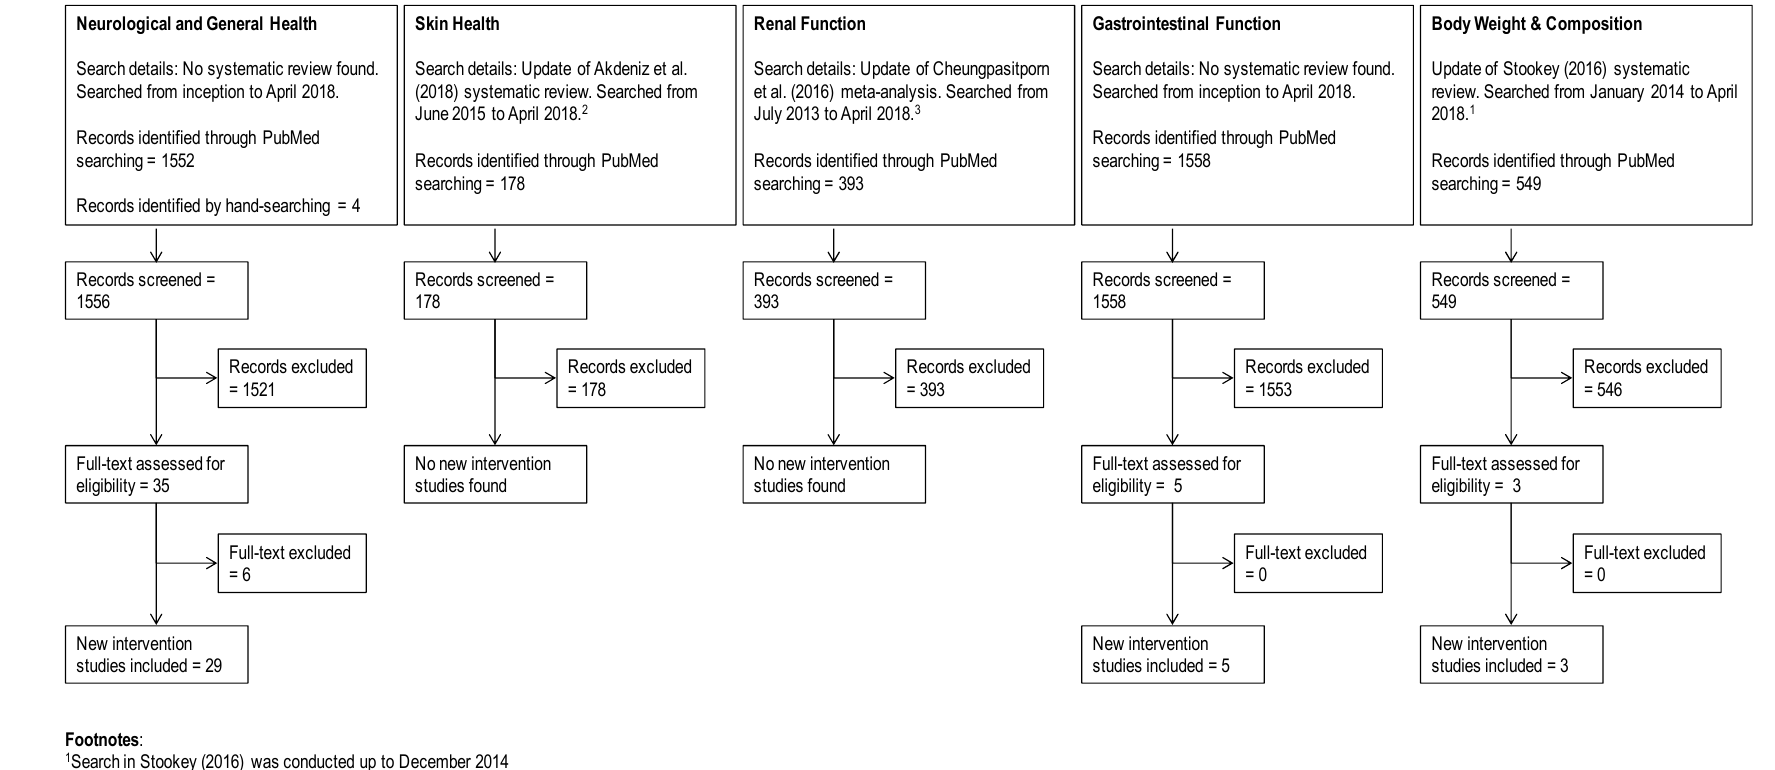
Figure 1. PRISMA flowchart.